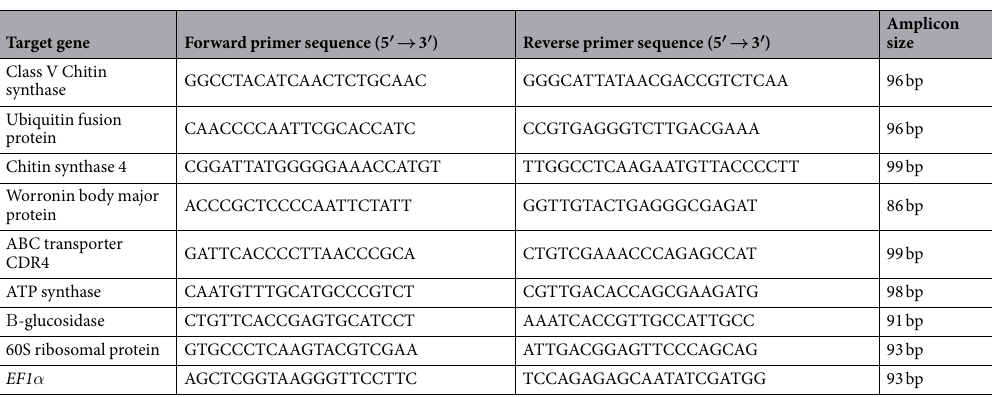
Table 5. Primer sequences of the virulence related genes of Foc and EF1 α (used as a reference gene) used for